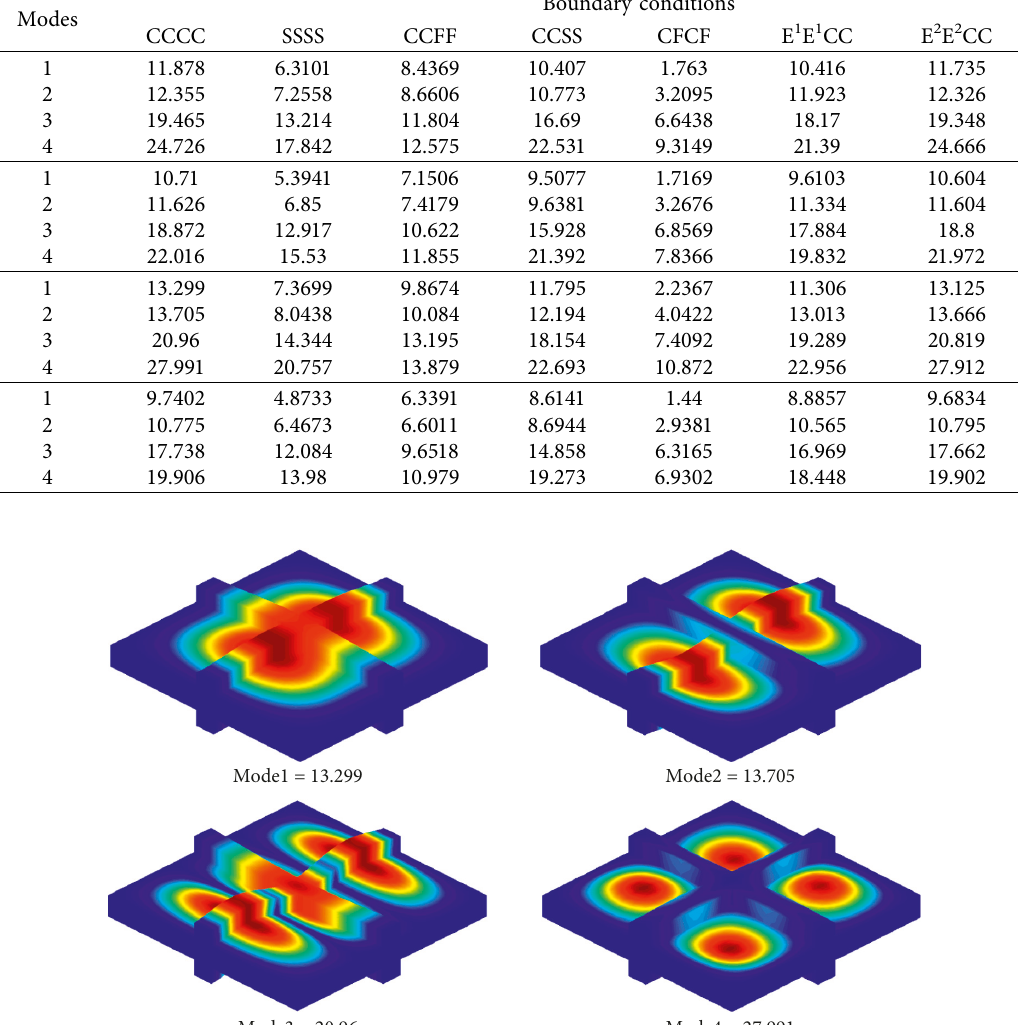
Table 8: The dimensionless frequencies of multi-stepped FG-CNTRC plate with different boundary conditions.